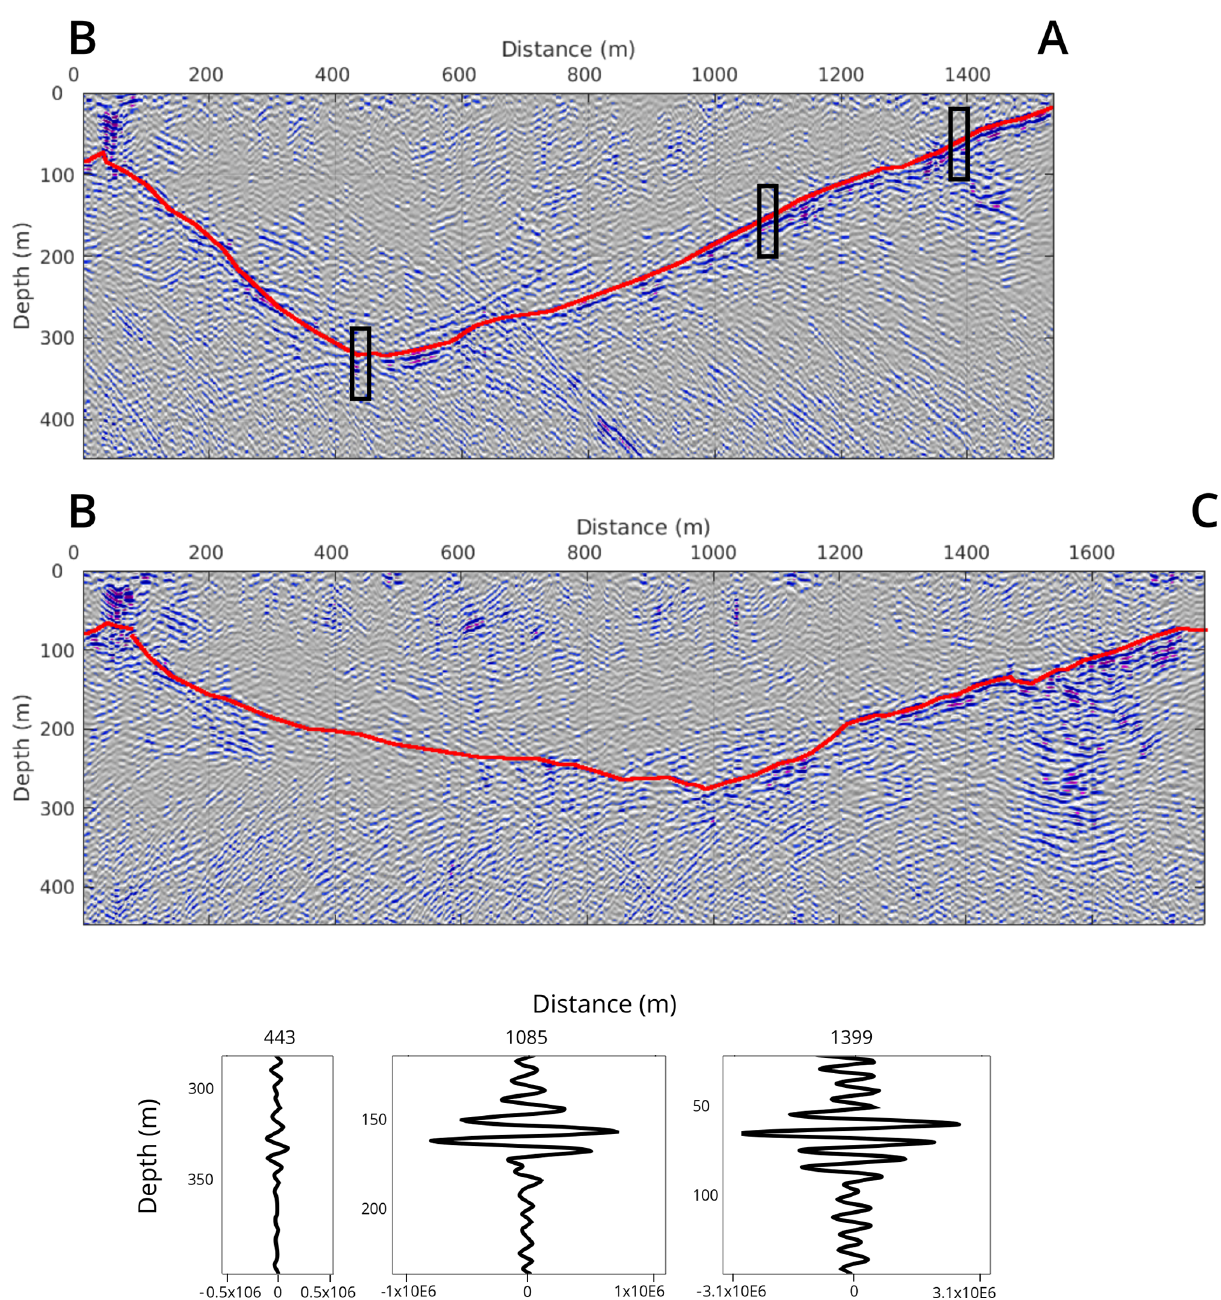
Figure 3. Resulting radargrams showing the manually interpreted bedrock in red. The x axis shows the distance covered during the mea- surements. The y axis represents the estimated bedrock depth in metres. The lower plot depicts A-scope examples of the attenuation of the signal at different depths from B to